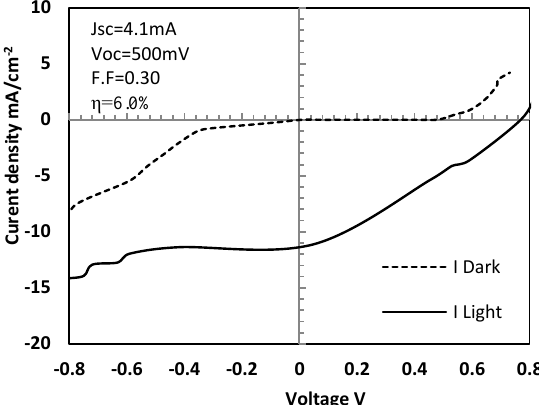
Fig. 8: I-V characteristics under dark and illumination for ZnO